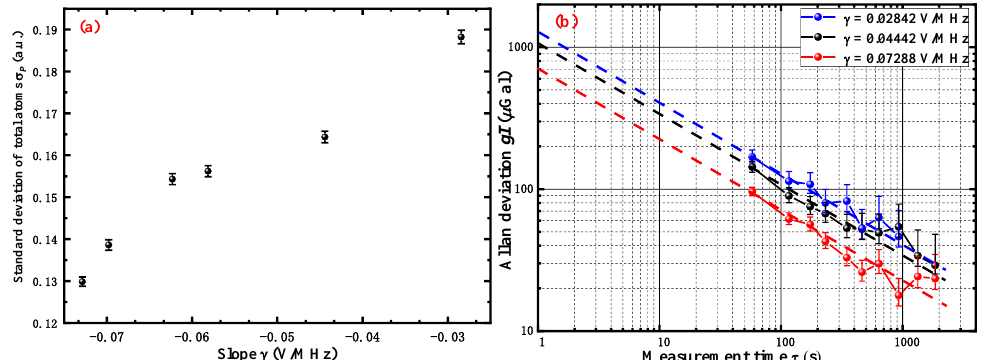
Figure 6. The Allan deviation of the gravimeter measurements and the fluctuation of the transition probability σ P . ( a ) The standard deviation of detection σ P with the slope γ . ( b ) The Allan deviation of the gravimeter measurement with the various slope γ . The dashed lines illustrate the τ − 1/2 scaling, which corresponds to the white noise.